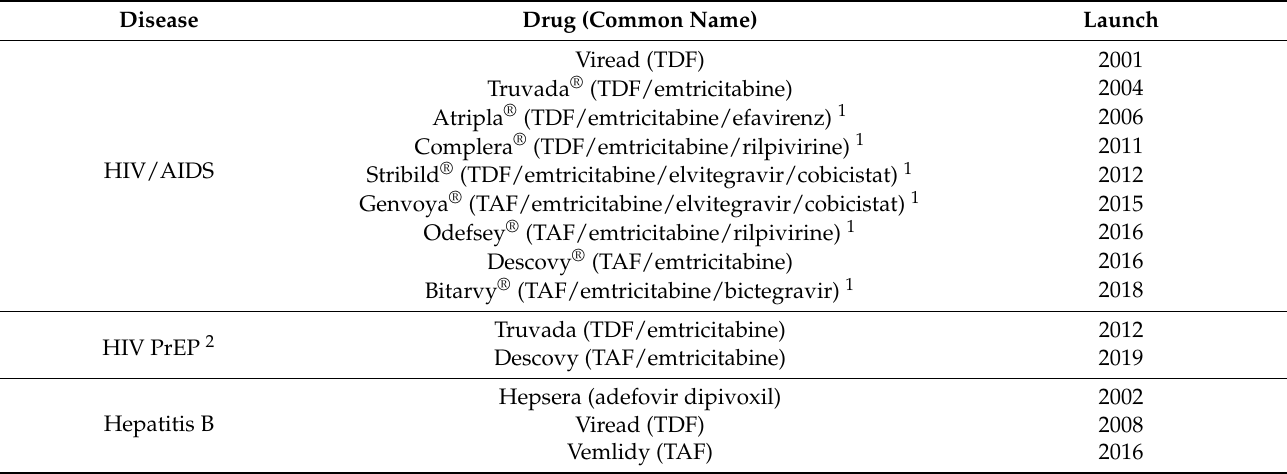
Table 1. Tenofovir-containing therapeutics for HIV and